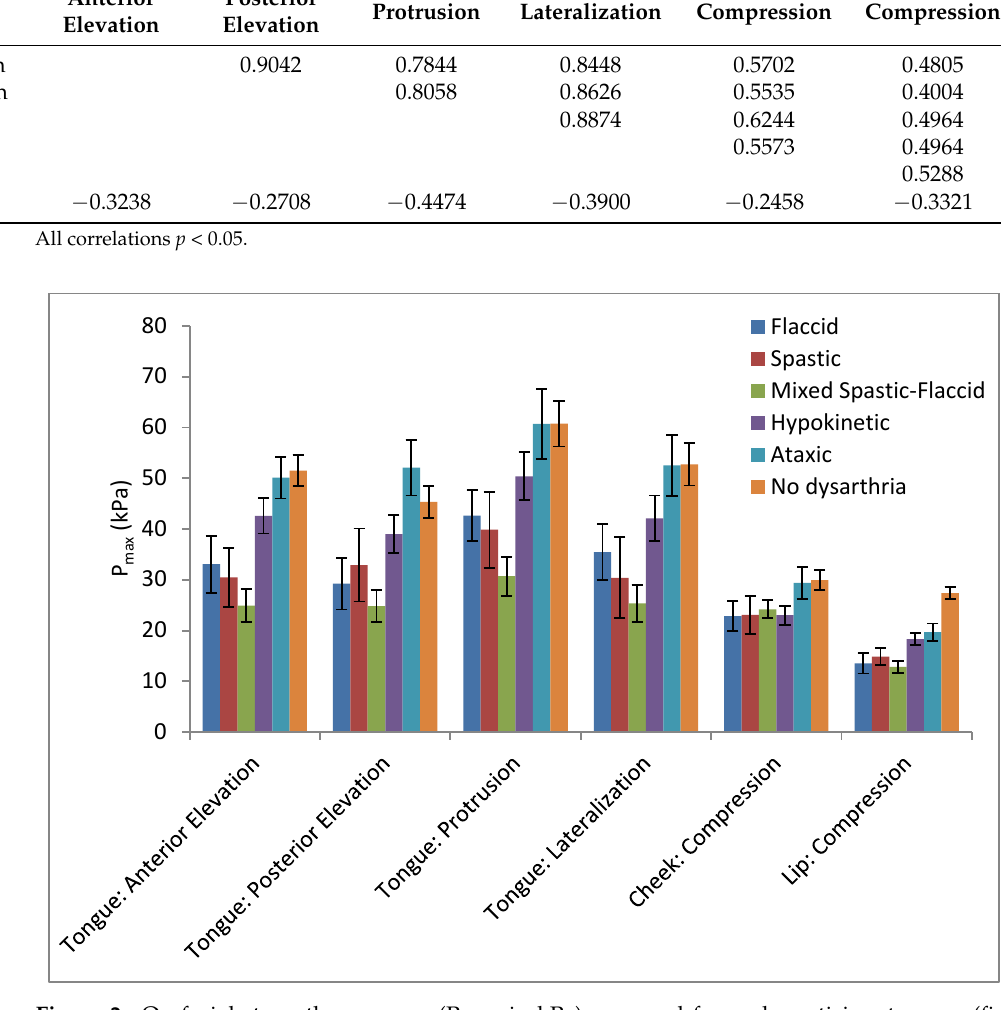
Figure 2. Orofacial strength measures (P max , in kPa) averaged for each participant group (five dysarthria types and one control group). Error bars reflect +/ − standard error.